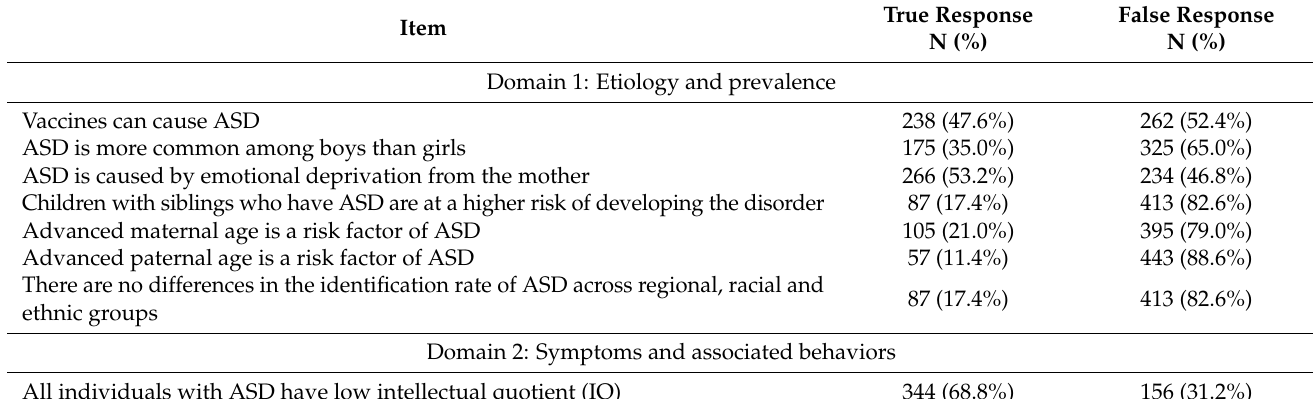
Table 4. Participants’ responses for knowledge